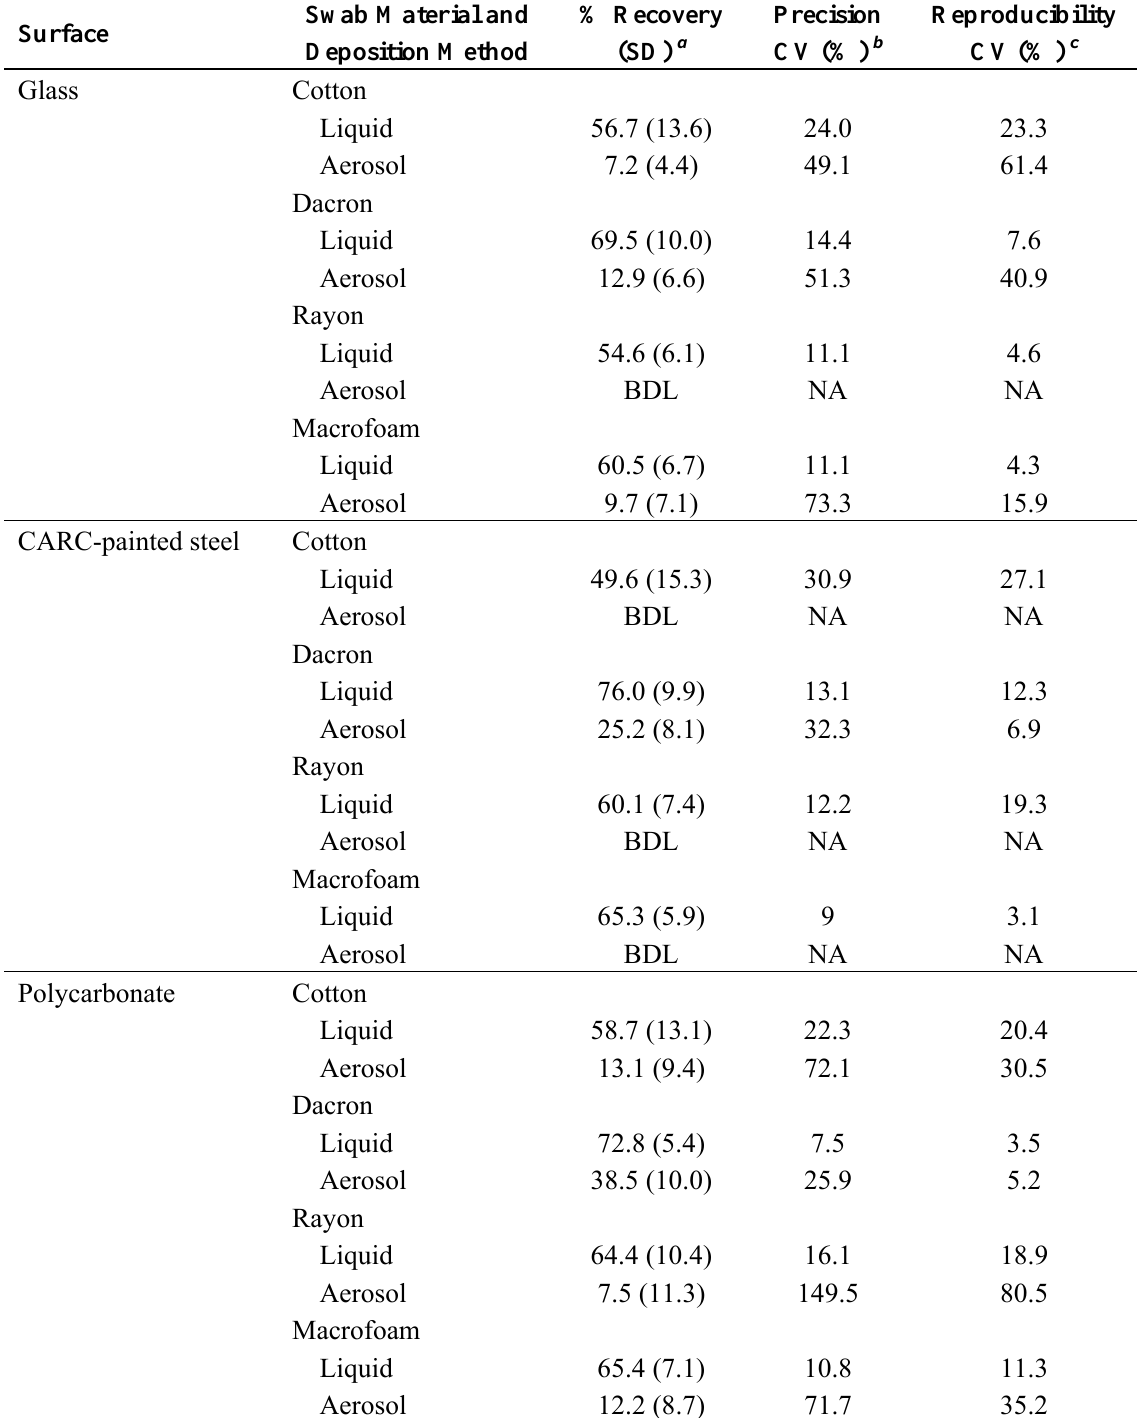
Table 1. Evaluation of recovery efficiency of cotton, dacron, rayon, and macrofoam swabs from glass, Chemical Agent Resistant Coating (CARC) painted steel, polycarbonate, and vinyl coupons deposited with liquid and dry aerosolized recombinant Ricin. Each combination of swab, surface material, and deposition method consists of 30 samples composed of three experimental replicates of 10 samples each. In every instance a statistical significance between recovery efficiencies of deposition method was confirmed at a confidence level exceeding